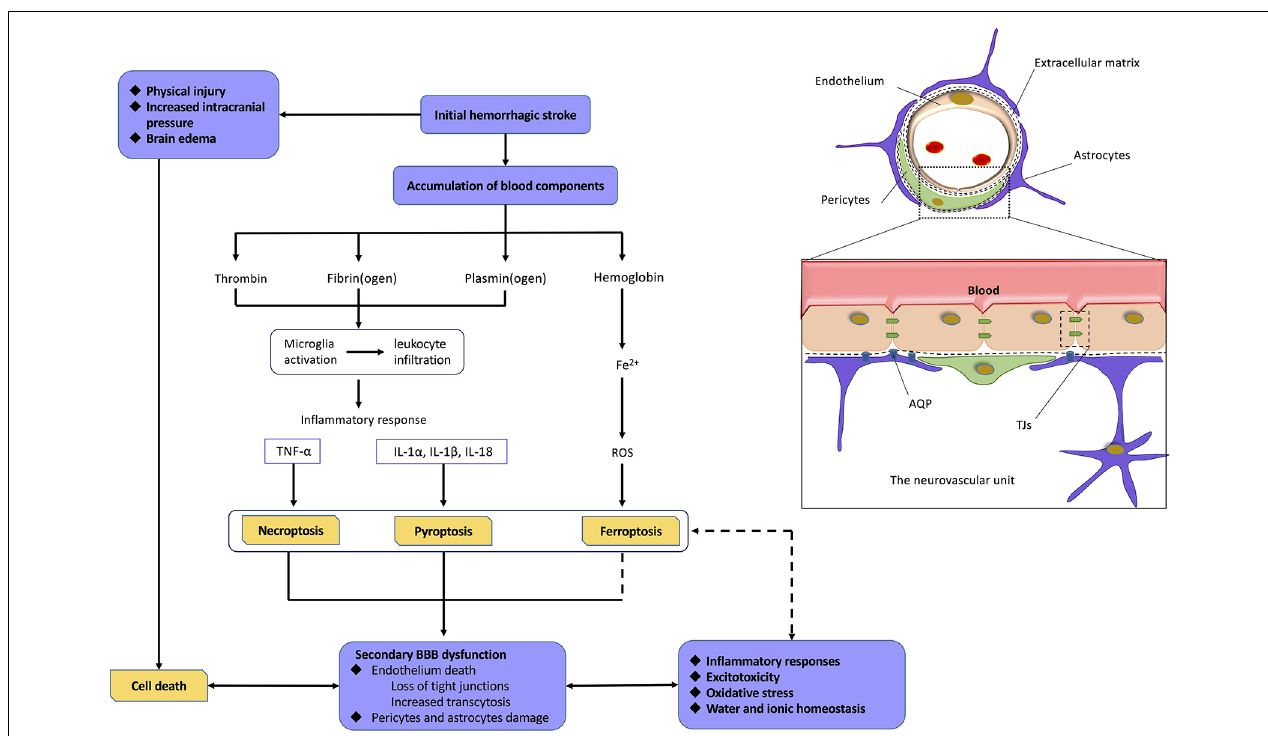
FIGURE 4 | Relationship among hemorrhagic stroke, programmed cell deaths, and blood–brain barrier (BBB) dysfunction. Normal neurovascular units (NVUs) are composed of intact endothelial cells (ECs), pericytes, astrocytic endfeet, and extracellular matrix (ECM) components. ECs, with their tight junctions (TJs), are the most important components. On the one hand, initial hemorrhagic stroke directly causes cell death in central nervous system (CNS) as a result of physical injury, intracranial pressure, and brain edema. On the other hand, abundant blood components can also mediate programmed cell deaths (PCDs) via proinflammatory response, reactive oxygen species (ROS), and so on. The death of cell, especially ECs, leads to severe damage on BBB. As a result, BBB dysfunction induces a variety of pathophysiological processes including inflammatory responses, excitotoxicity, oxidative stress, water, and ionic homeostasis, which finally mediate more extensive PCDs. Abbreviations: TNF α , tumor necrosis factor; IL-1 α /1 β /18, interleukin 1 α /1 β